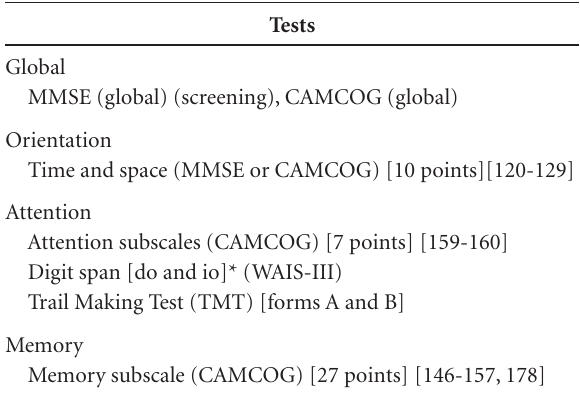
Table 2. Protocol B (see text for original references, translations and